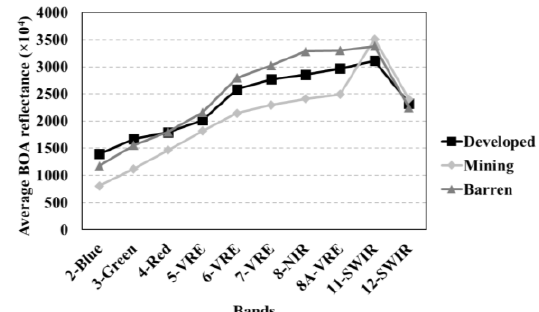
Figure. 4. The average BOA reflectance of each band for developed, mining, and barren based on all sample points.